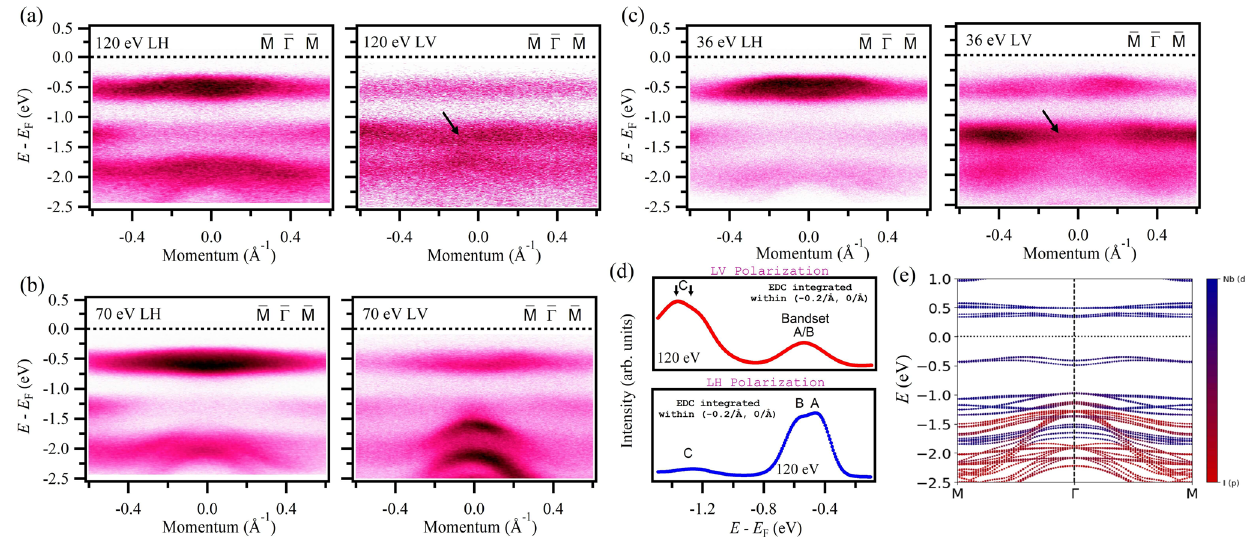
Fig. 4 Polarization-dependent band dispersion. a – c ARPES measured band dispersions along M (cid:1) Γ (cid:1) M measured using photon energies of 120, 70, and 36 eV, respectively, using LH or LV polarization as noted on each plot. d Fits of integrated EDCs (Voigt fi ts) taken within a momentum window of ( − 0.2/ Å – 0/ Å ) for 120 eV LH polarized (bottom) and LV polarized (top) data in ( a ) [also see Supplementary Fig. 9]. e Calculated orbital-resolved dispersion along M − Γ − M. ARPES data were collected at the ALS beamline 4.0.3 at a temperature of 260